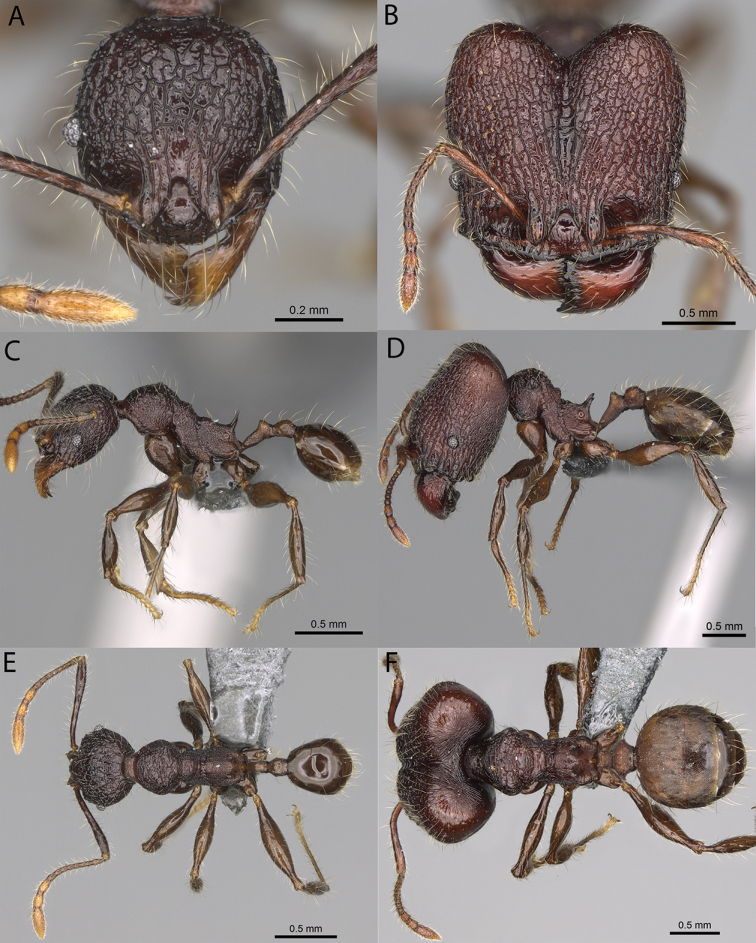
Pheidole
diakritos sp. nov., full-face view (A), profile (C), and dorsal view (E) of paratype minor worker (CASENT0275480) and full-face view (B), profile (D), and dorsal view (F) of holotype major worker (CASENT0275436).